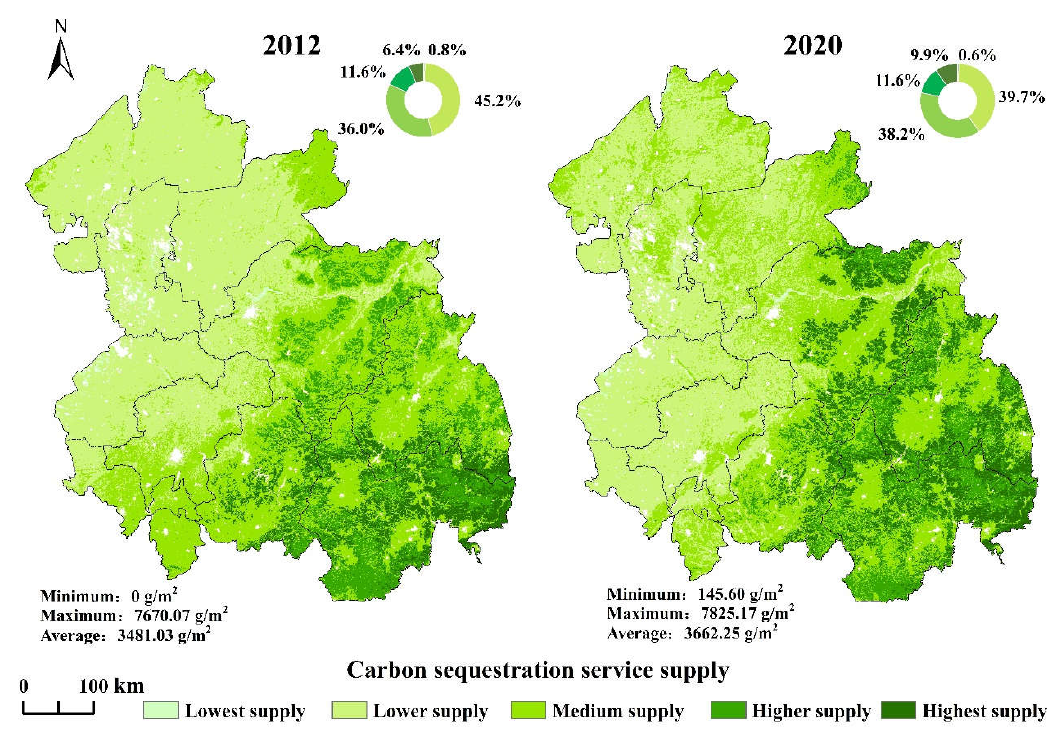
Figure 2. The spatial and temporal patterns of carbon sequestration service supply. Table 2. Five levels of supply and demand.